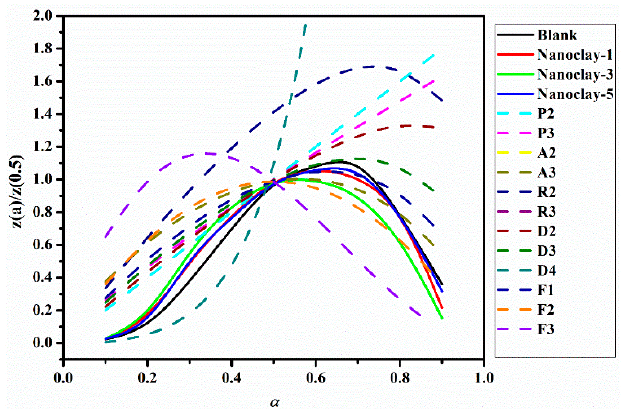
Figure 6. Theoretical master plots of different reaction models and experimental reduced rate plot at 5 °C/min for blank PU and its prepared nanocomposites. Table 3. Decomposition parameters based on the Sestak-Berggren decomposition reaction of PU nanocomposites calculated using different iso-conversional kinetic